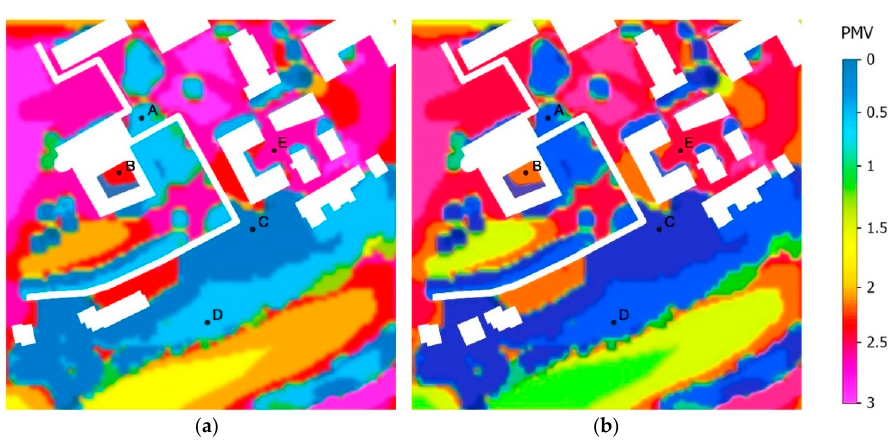
Energies 2017 , 10 , 351